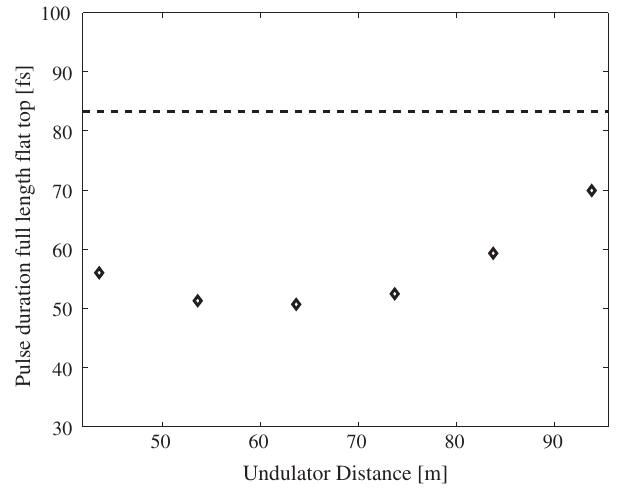
FIG. 7. Measured x-ray pulse duration vs undulator distance (diamonds). Pulse duration expressed as full length flattop. Electron bunch length within the flattop model